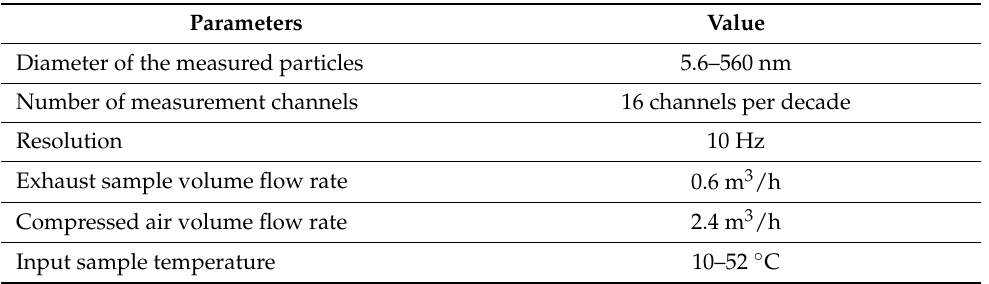
Table 5. Technical data of the EEPS 3090 analyzer [33].